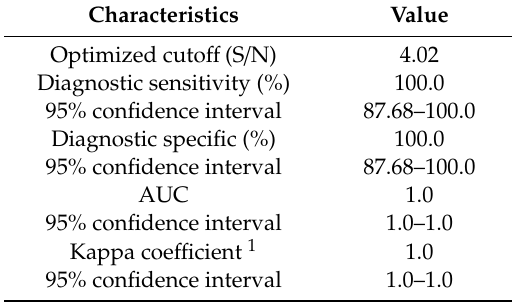
Table 2. ROC and kappa coe ffi cient data for LIPS with N protein